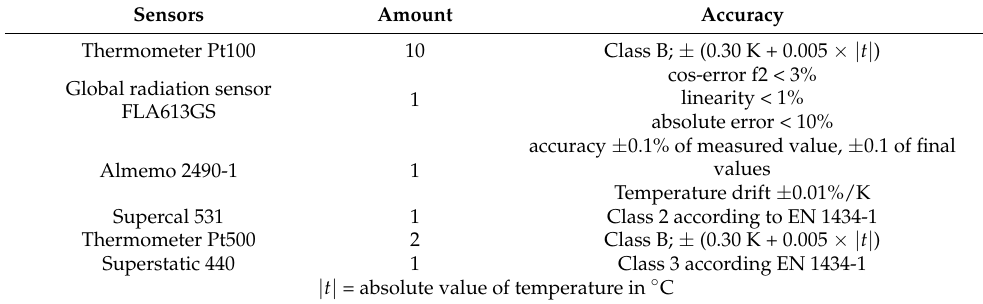
Figure 2. Location of the tracker structure on the roof of the laboratory: ( a ) rotation mode, ( b ) static state without rotation, ( c , d ) effect of the ambient constructions in the morning for the given period (shooting date 5 October and 15 October 2018 at 10:00—equivalent of months February and March— sun low above horizon, in spring less leafing of trees than in autumn). Table 1. List of measuring devices, sensors and their